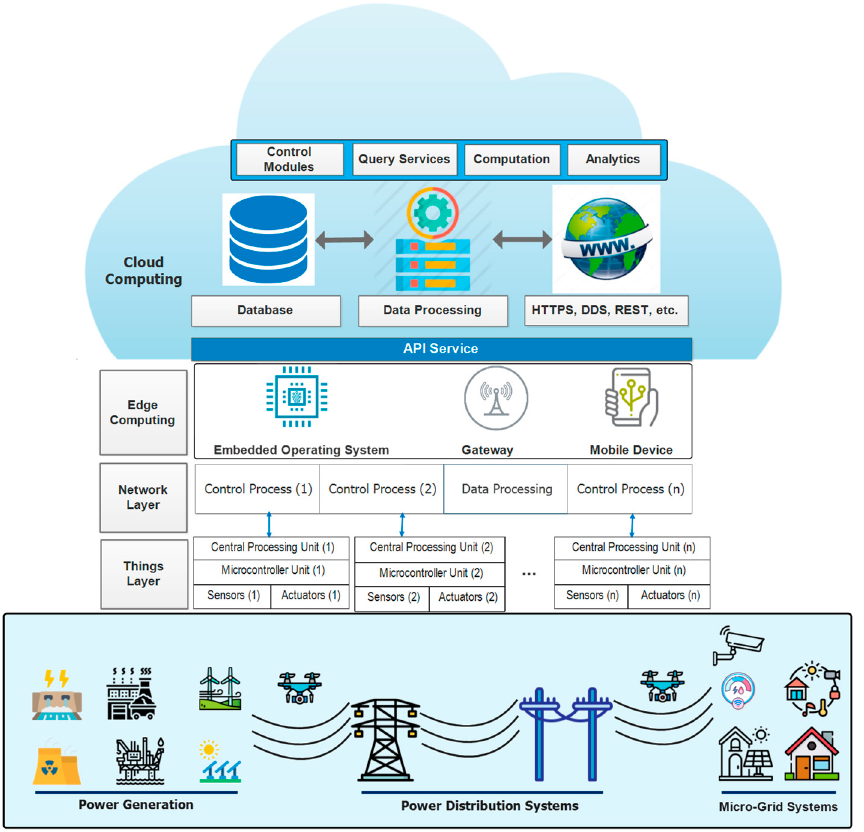
Figure 4. The all-in-one computing architecture for IoT-based SG.